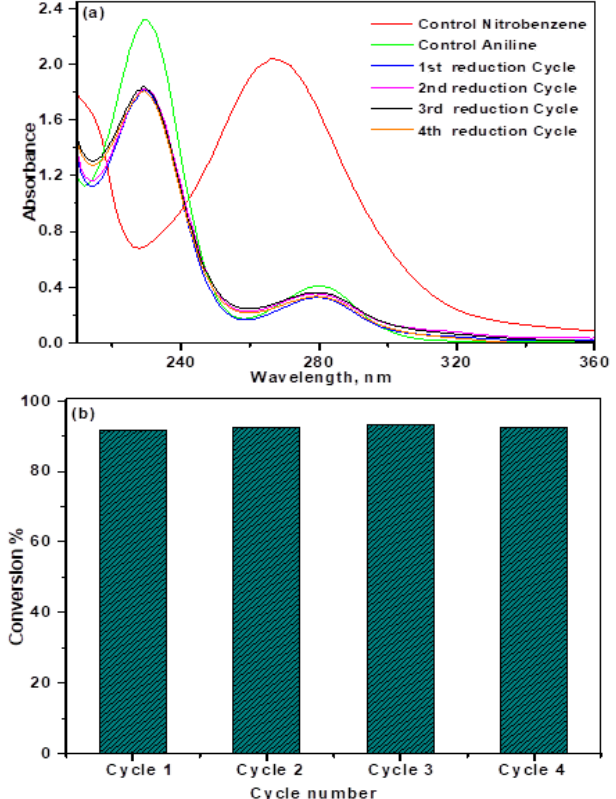
Figure 9. Reusability of the PSE-capped Cu 2 O / CuO catalyst: ( a ) UV-vis absorption spectra of the reduction of NB for successive 4 cycles and ( b ) conversion (%) of NB reduction for each cycle using the PSE-capped Cu 2 O/CuO catalyst.